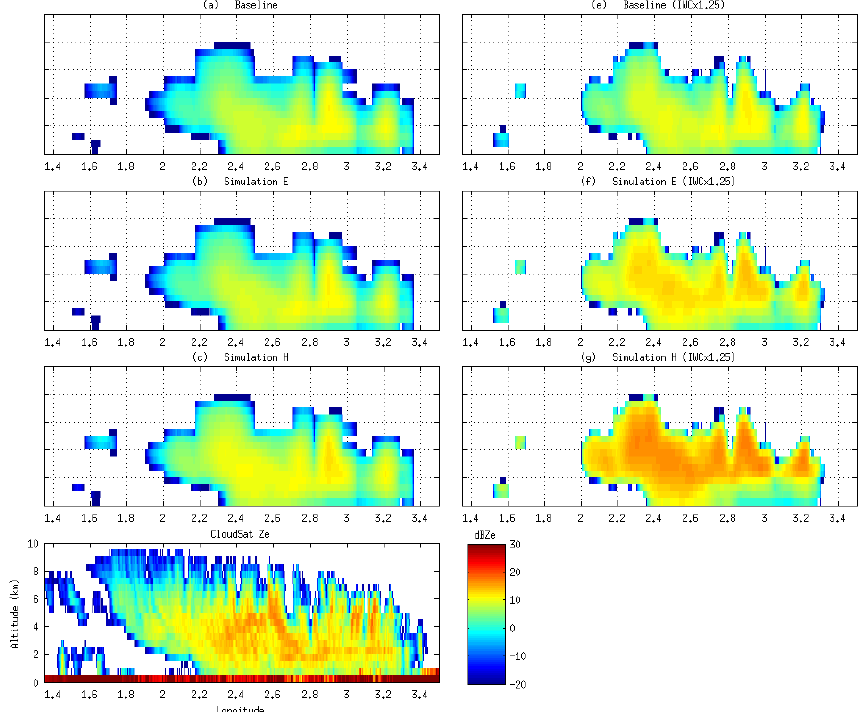
Figure 7. The simulated CPR (94GHz) radar reflectivity is shown in panels (a)–(f) . See Table 2 for more information on each of the simulations illustrated. The CloudSat CPR radar reflectivity (94GHz) is also shown in (g) downscaled to the Meso-NH resolution for